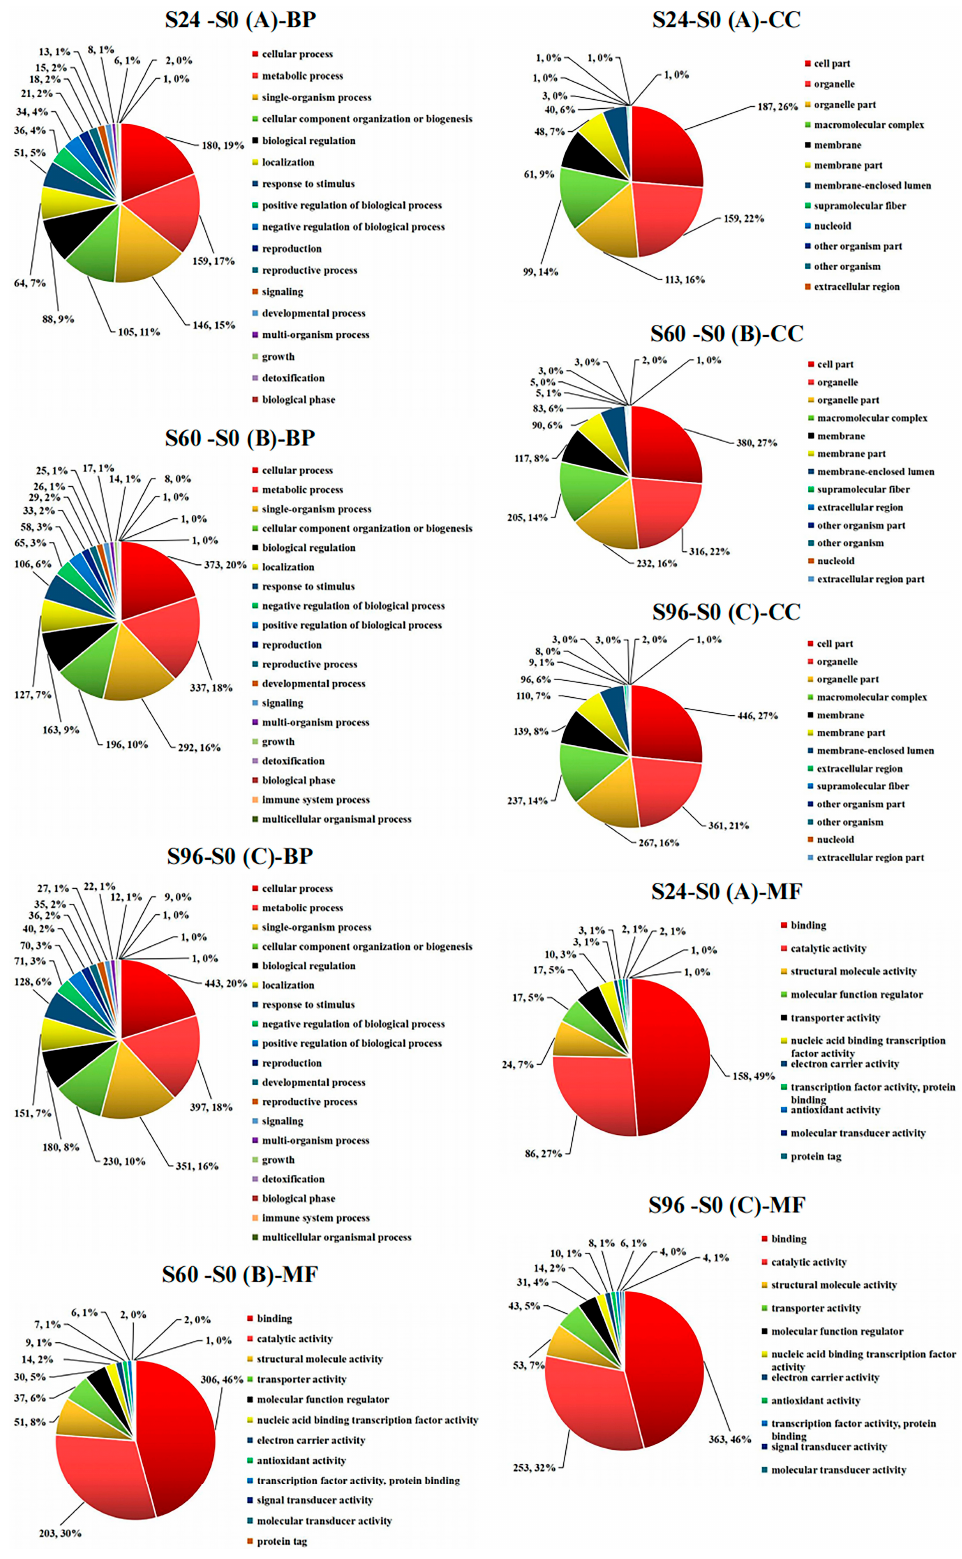
Figure 5. Bioinformatics analysis of GO terms for the aforementioned DEPs in three domains: BP, MF, 1 and CC. The statistics at GO level 2 are shown in this figure. A: S24–S0; B: S60–S0; and C: S96–S0. In general, compared with the proteins identified in the 0 h samples, the contents of DEPs involved in biological processes, cell components, and molecular functions gradually